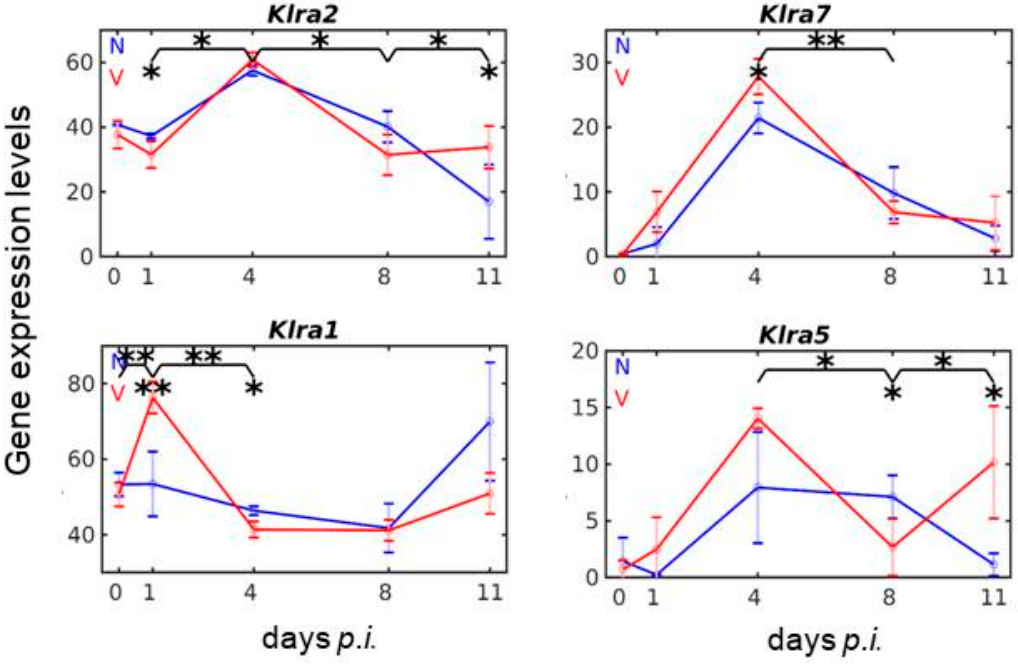
Figure 4. Expression trajectories of genes encoding members of the KLRA receptor family involved in MHCIa-dependent tissue surveillance. RNA was isolated from individual livers prepared from vaccination-protected (V, red) and non-vaccinated (N, blue) mice infected with P. chabaudi blood-stage malaria on days 0, 1, 4, 8, and 11 p.i. Gene expression levels in linear scale are plotted as the means of three microarrays ± SD. The number of “*” marks over interval lines between two sampling points and over the sampling points, respectively, indicate statistical significance of two corresponding intervals and of a given sampling point, respectively, between vaccinated and non-vaccinated mice: * p < 0.05; ** p < 0.01.